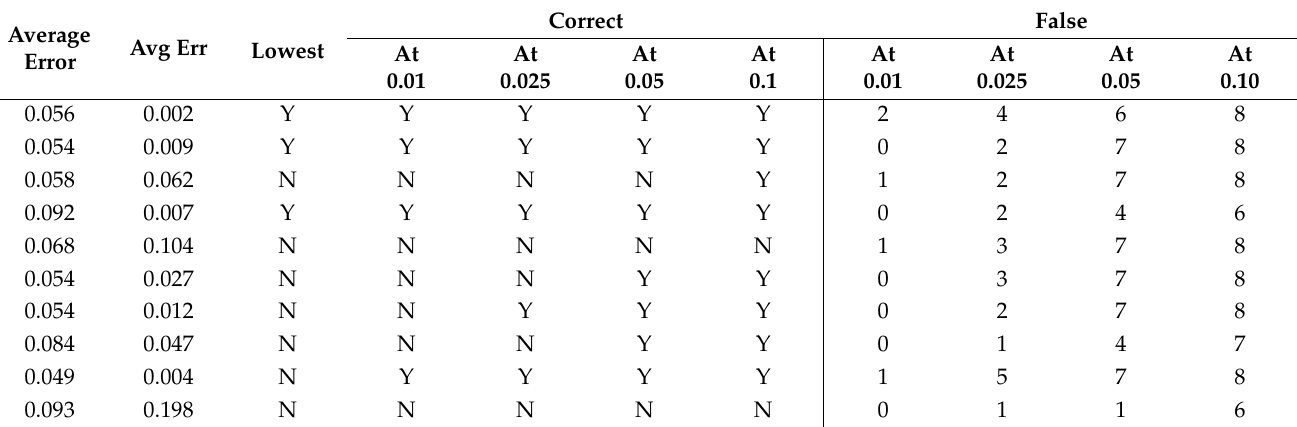
Table 8. Set 3, trials 11–20 summary data (actual PR